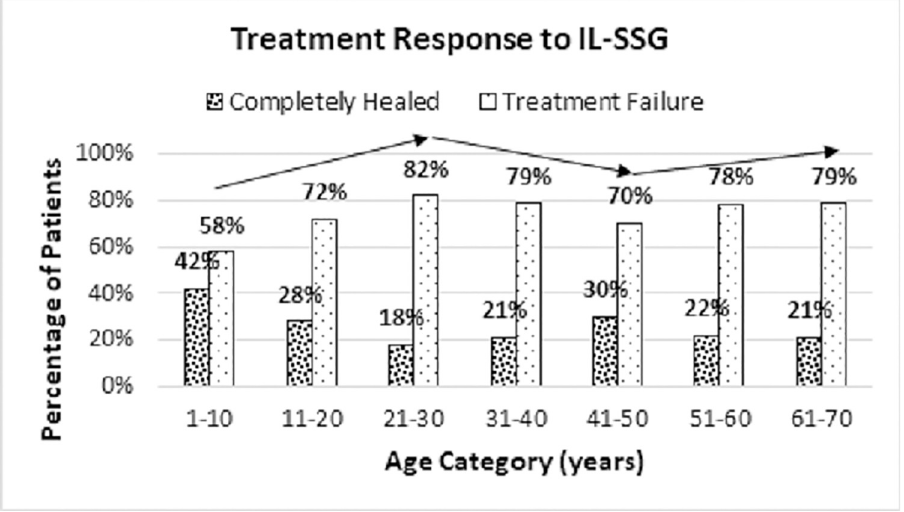
Fig 1. Treatment response to IL-SSG with